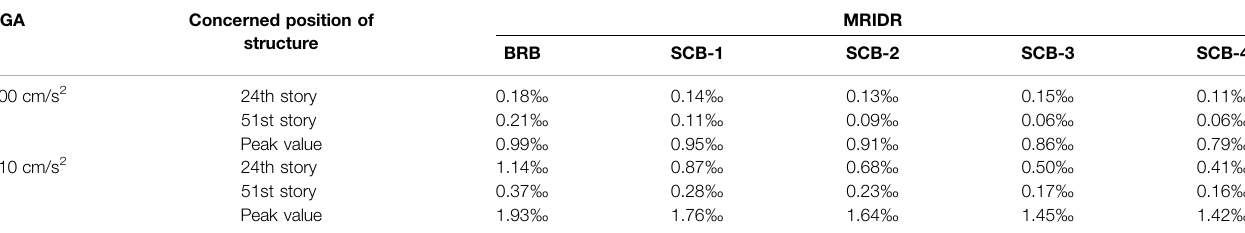
TABLE 6 | MRIDRs of study cases.